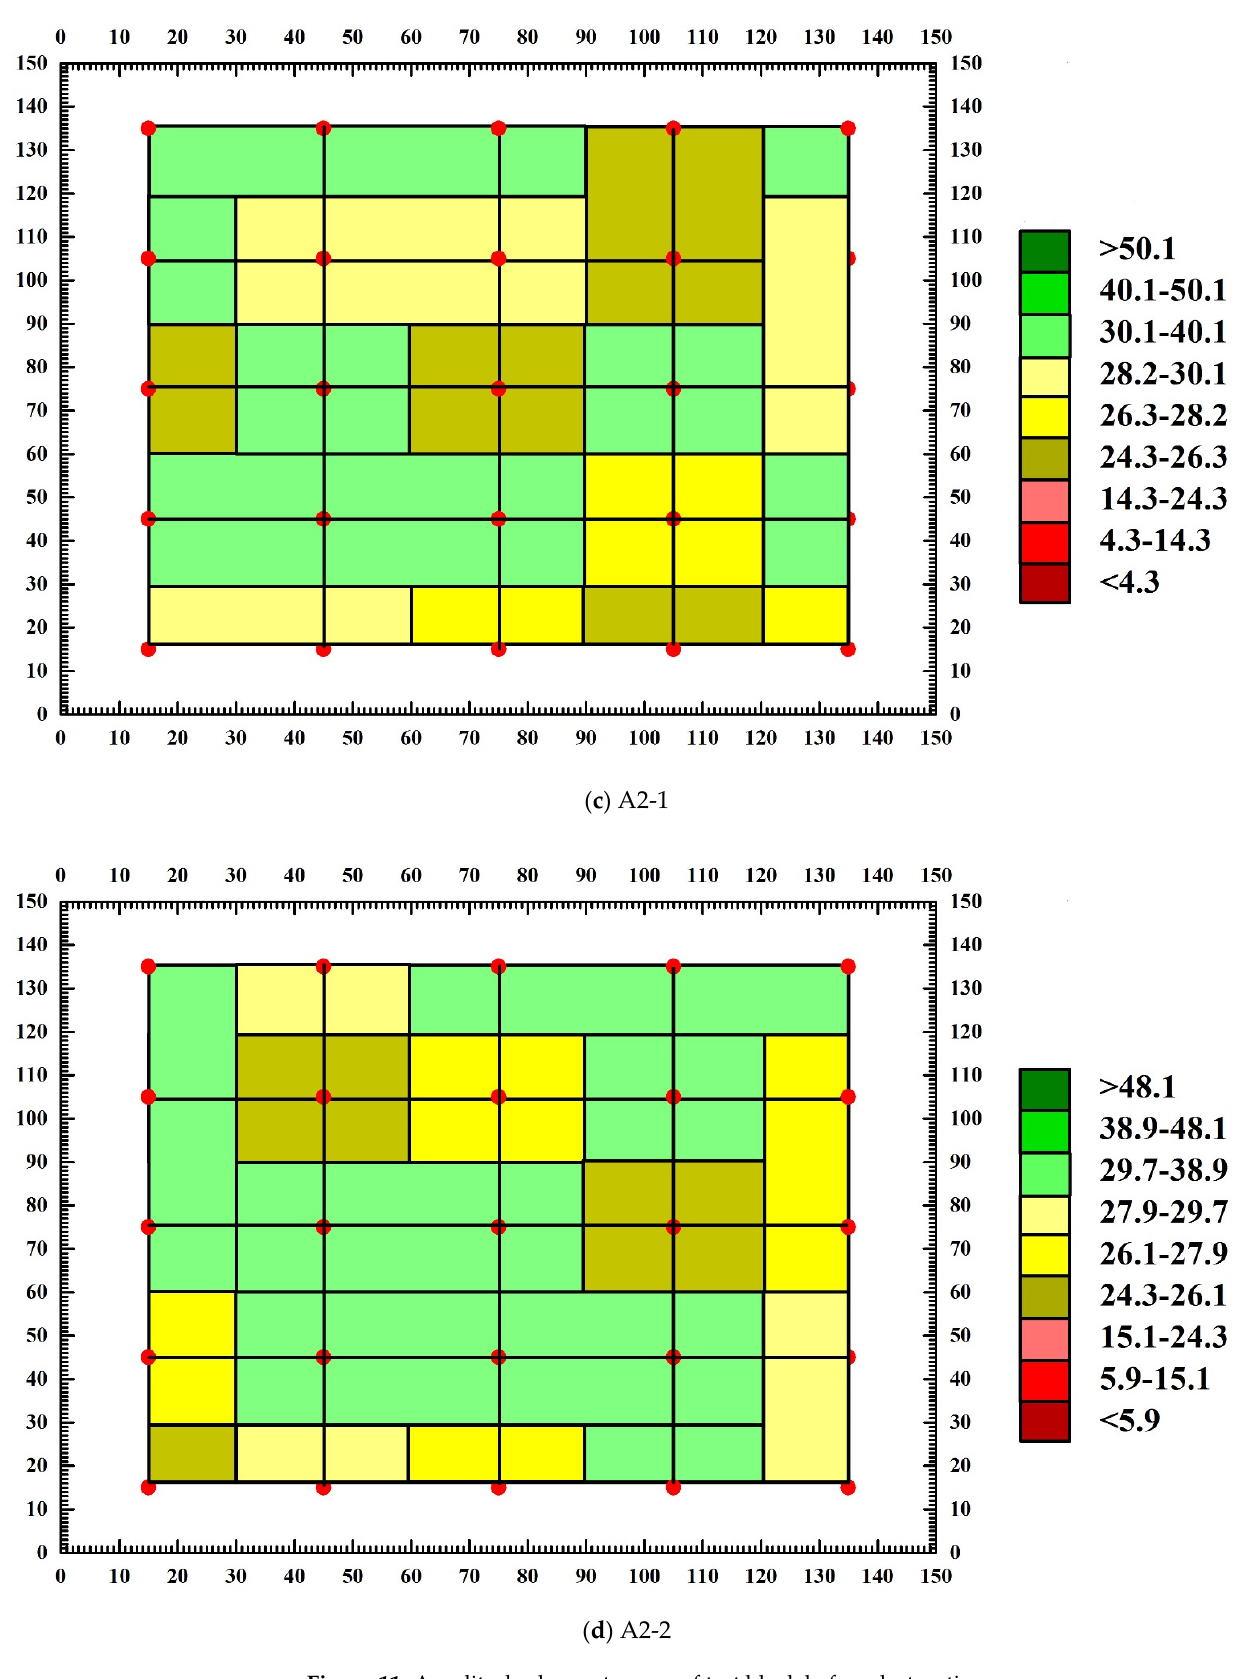
Figure 11. Amplitude chromatogram of test block before destruction.